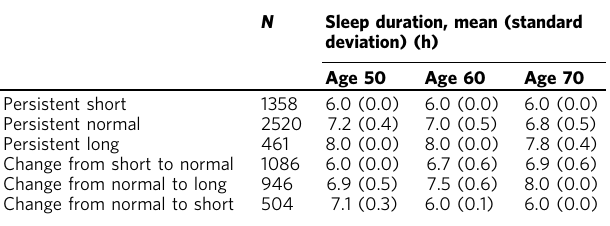
Table 3 Description of sleep duration at age 50, 60, and 70 by groups of trajectories of sleep